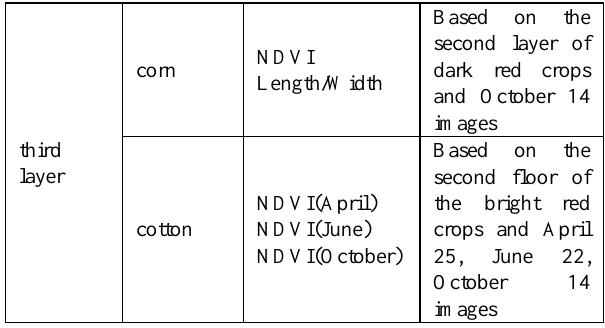
Table 6.Build a classifier layer by layer